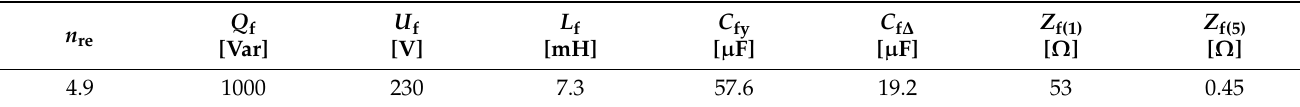
Table 1. Computed equivalent parameters of the single-tuned filter (one-phase).